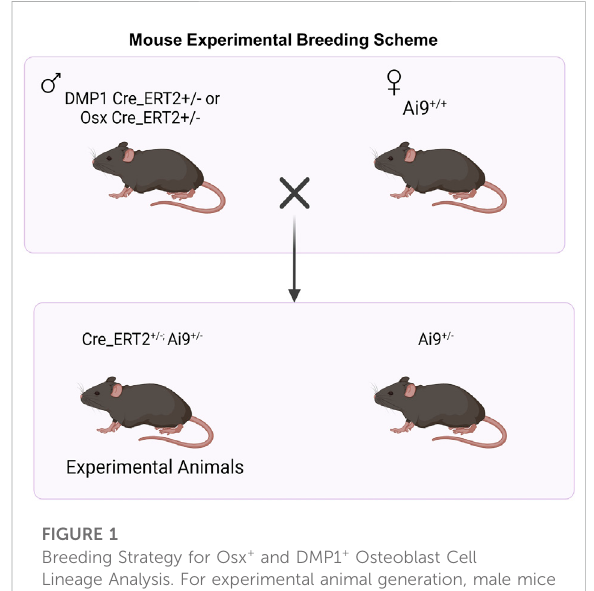
FIGURE 1 Breeding Strategy for Osx + and DMP1 + Osteoblast Cell Lineage Analysis. For experimental animal generation, male mice hemizygous for inducible Cre (Cre_ERT2 +/ − ) were crossed to femalemicecontaininghomozygousAi9alleles(Ai9 +/+ ).Male and female mice hemizygous for Osx or DMP1 Cre_ERT2 and containing the Ai9 allele were utilized for experiments. + = presenceoftransgene;-=absenceoftransgene.Figurecreatedin